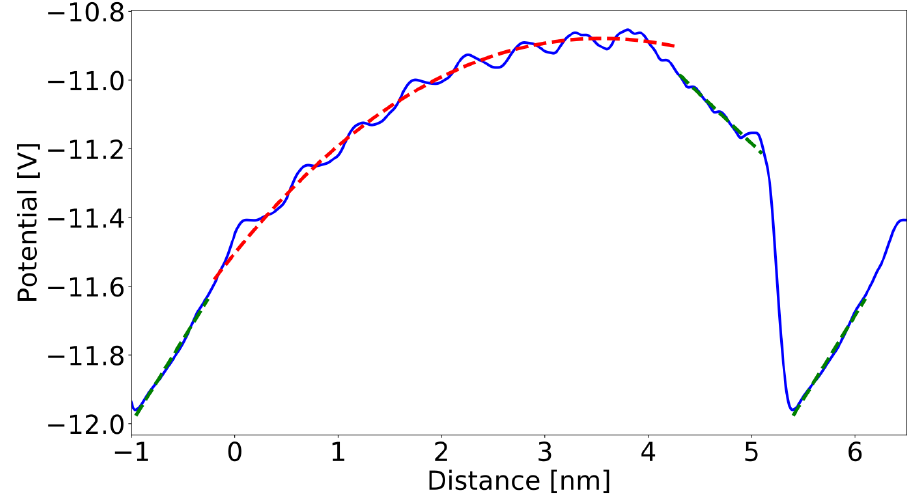
Figure 3. The averaged potential profile obtained from ab initio calculations of the structures in Figure 1a. The zero coordinate value is set at the bottom of the cell. Solid blue lines represent averaged potential profiles, red dashed lines — parabolic approximation in the graded regions; green dashed lines — linear approximation in the uniform regions. The averaged composition of the atomic layers is presented in Figure 2. The graded region consist of eight unit cells in which the In concentration changed from 0 to 0.5.